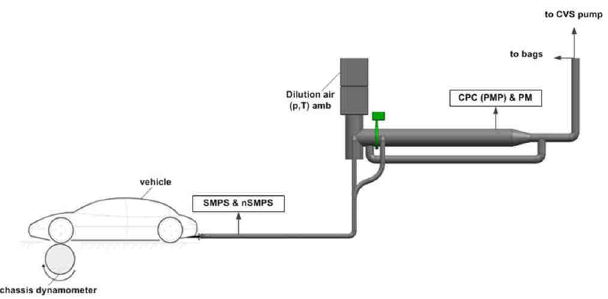
Fig. 3. Sampling of exhaust gas for analysis of